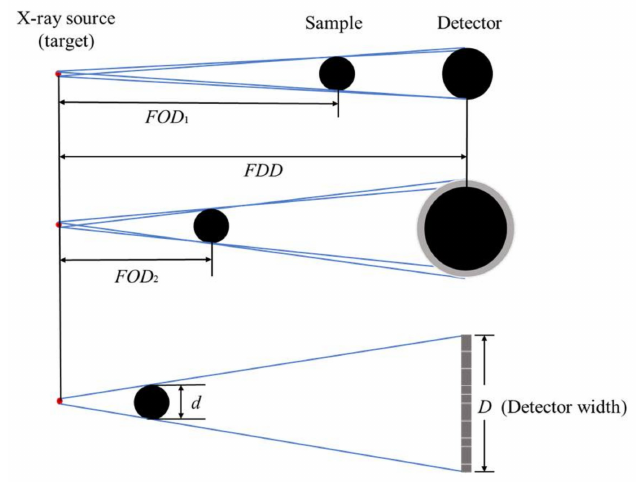
Figure 5. Image magnification for CT